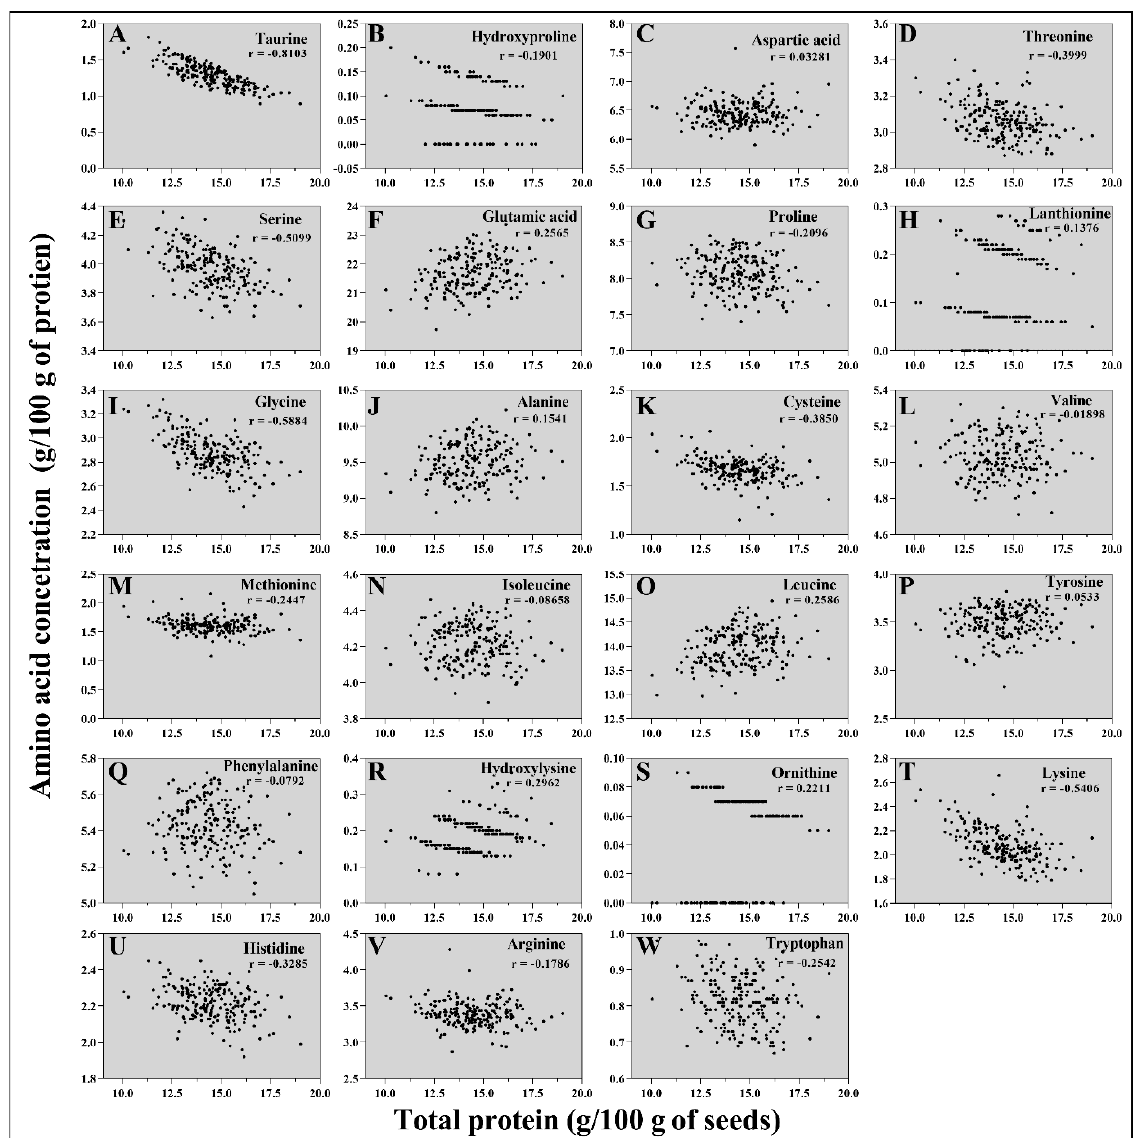
Figure 5. Correlations between the concentrations of amino acids (%), taurine ( A ), hydroxyproline ( B ), aspartic acid ( C ), threonine ( D ), serine ( E ), glutamic acid ( F ), proline ( G ), lanthionine ( H ), glycine ( I ), alanine ( J ), cysteine ( K ), valine ( L ), methionine ( M ), isoleucine ( N ), leucine ( O ), tyrosine ( P ), phenylalanine ( Q ), hydroxylysine ( R ), ornithine ( S ), lysine ( T ), histidine ( U ), arginine ( V ), and tryptophan ( W ), and the total protein concentration (g/100 g of seeds) in the seeds of mutant lines. Each point indicates the amino acid concentration in each mutant line. The r value represents the Pearson correlation.